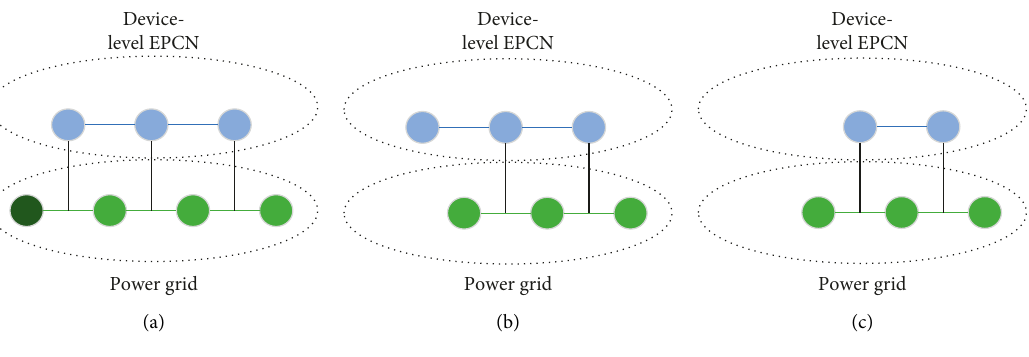
Figure 5: Cascading process of physical node failure.